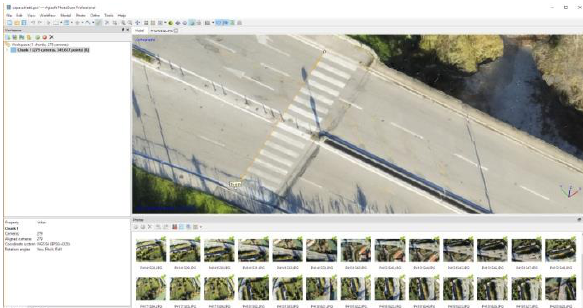
Figure 8: the measurement taken by the drone model without applying the GPS point correction is 15.6 meters.